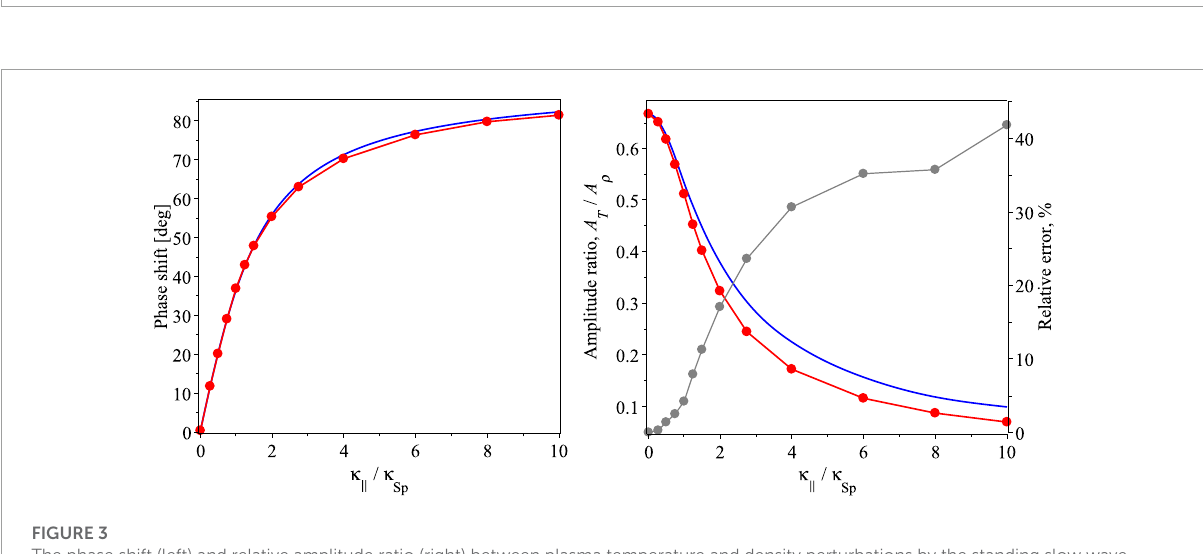
FIGURE 3 The phase shift (left) and relative amplitude ratio (right) between plasma temperature and density perturbations by the standing slow wave, obtained from the analysis of the numerical solution of Eqs 1 – 4 with full thermal conductivity as described in Section 3 (in red) and from the approximate analytical solutions Eqs 5 – 6 in a weakly conductive limit (in blue). The grey curve in the right panel shows the relative error between the estimations of the temperature and density relative amplitude ratio, shown in red and